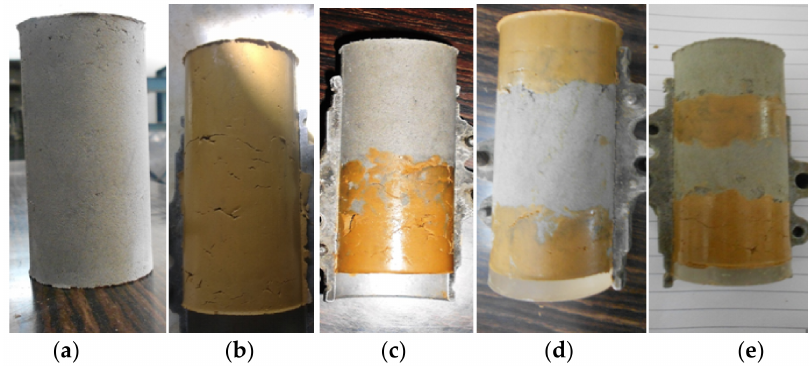
Figure 7. Specimen before saturation of: ( a ) fly ash, ( b ) bentonite, ( c ) F:B = 1:1 in N = 1, ( d ) F:B = 1:1 in N = 2, and ( e ) F:B = 1:1 in N = 3.